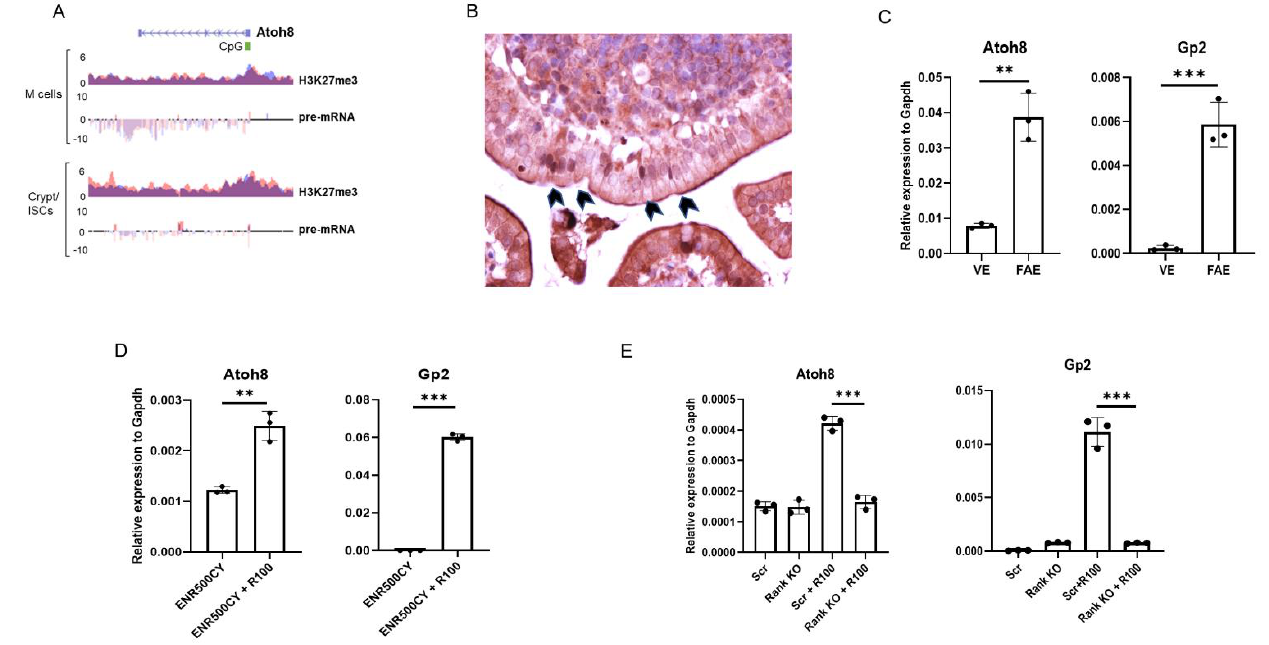
Figure 1. Atoh8 is expressed in FAE in Peyer’s patches and is dependent on Rank-RankL signaling. ( A ) H3K27me3 occupancy at CpG islands spanning the promoter and first exon of the Atoh8 gene in organoids treated with RankL (M cells) or treated with Wnt3a and Chir99021 (Crypt/ISCs). Below, pre-mRNA expression of Atoh8 in organoids treated as above (y-axis: normalized tag count, ENR500 = R-spondin 500 ng/mL, R100 = Rankl 100 ng/mL). ( B ) Section of PP from wild type mice stained with Atoh8 antibody. Arrowheads indicating Atoh8 expression in the nuclei of M cells in FAE. ( C ) RT-qPCR analysis of Atoh8 and Gp2 in the FAE and VE from C57BL/6JRj mice ( n = 3). ( D ) Organoids generated from wild type mice were stimulated with 100 ng of RankL for 4 d. Atoh8 and Gp2 expression was examined by RT-qPCR analysis. ( E ) Rank KO organoids and Scrambled organoids generated by lentiCRISPR v2 were incubated with RankL for 4 days, Atoh8 and GP2 expression was analyzed by RT-qPCR. In panels ( C – E ), unpaired two-tailed Student’s t -test was performed for three independent experiments, *** p < 0.005; ** p < 0.01.